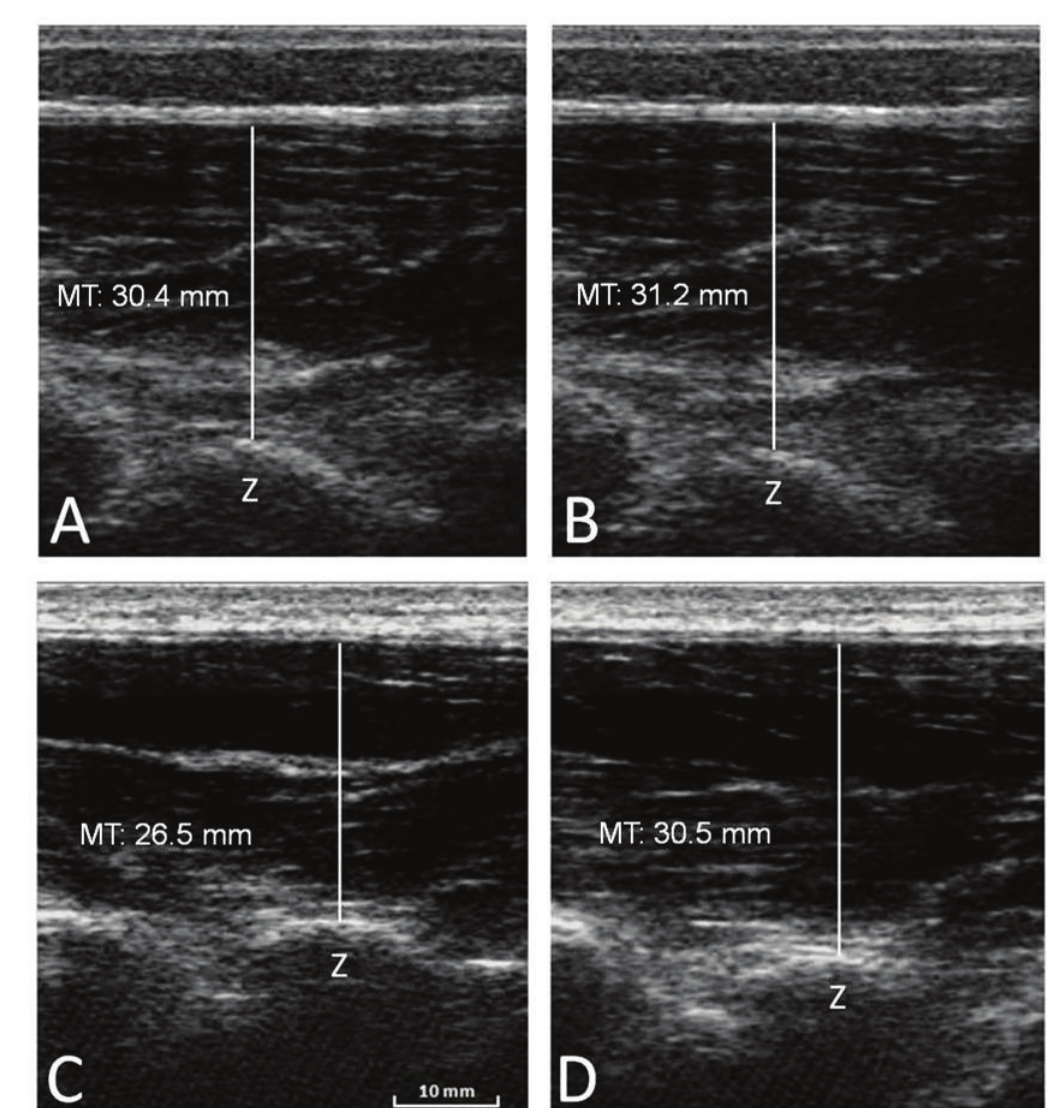
Figure 3. Ultrasound images of the multifidus muscle at rest (A,C) and during the PBU test (B,D) of a representative athlete from the CON (A,B) and from the TLS (C,D) groups, respectively. Z = zygapophyseal joint; MT = multifidus muscle